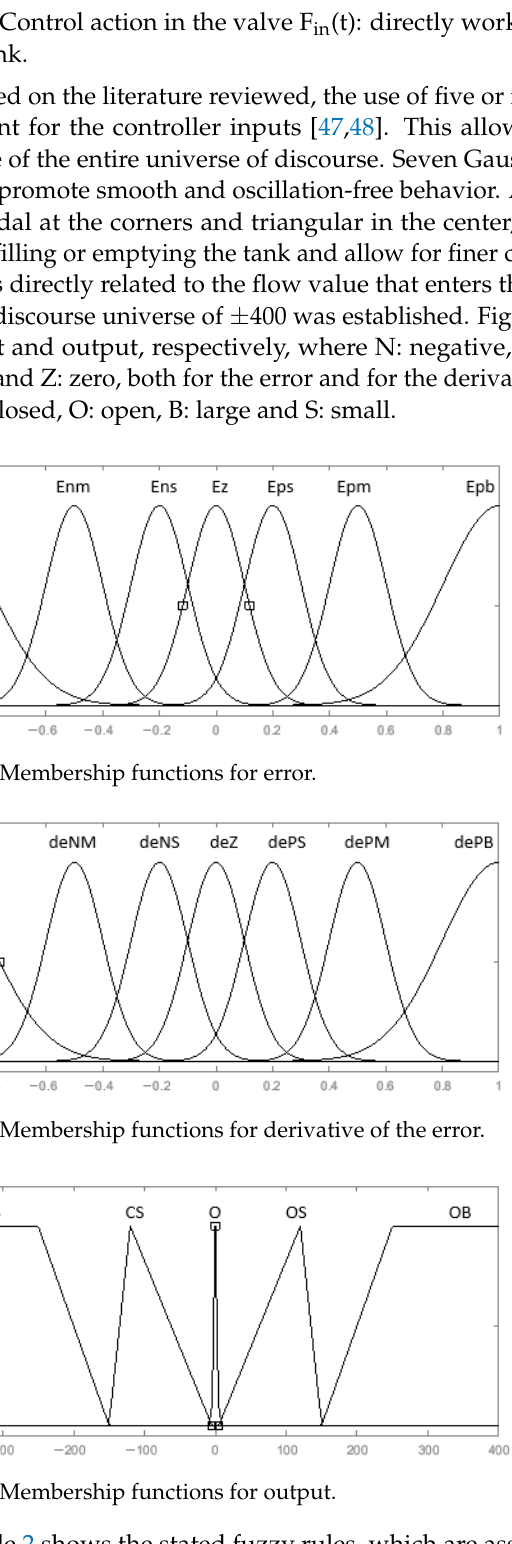
Figure 3. Fuzzy controller designed. ( a ) Diagram of FLC controller. ( b ) Block diagram of implemen- tation in Simulink.